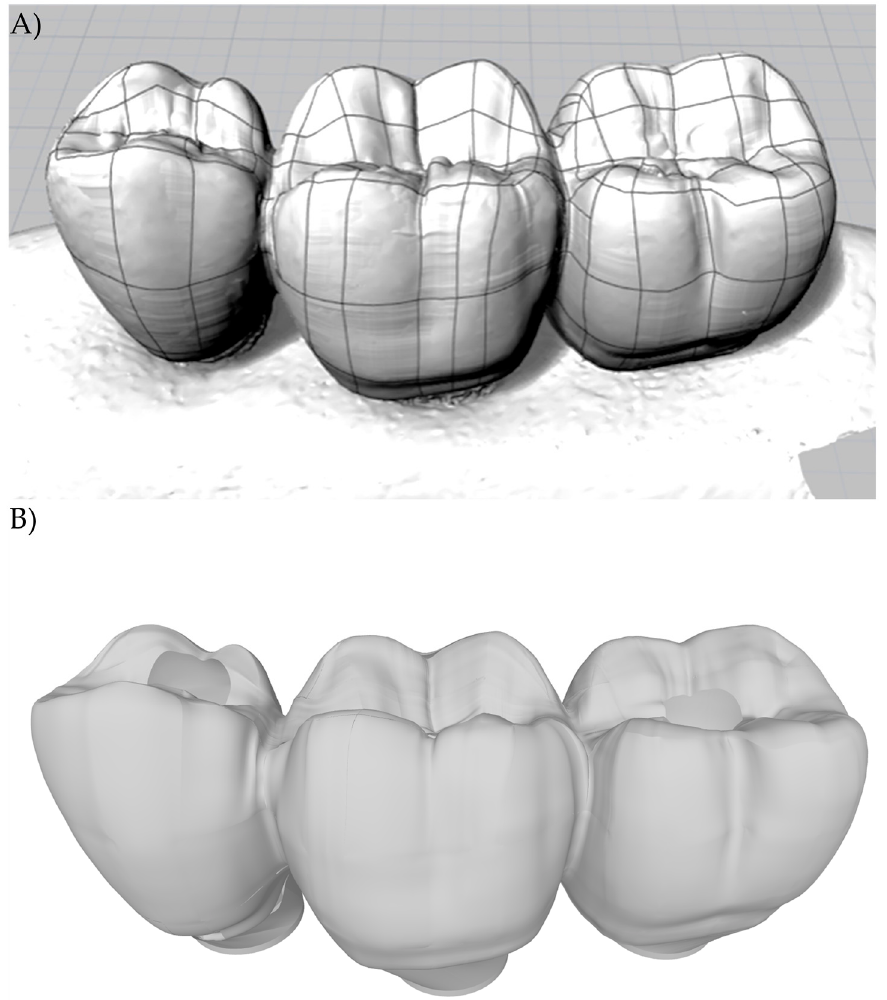
Figure 2. ( A ) Lines and meshes over the.STL file; ( B ) 3D model of the 3-unit fixed partial denture.